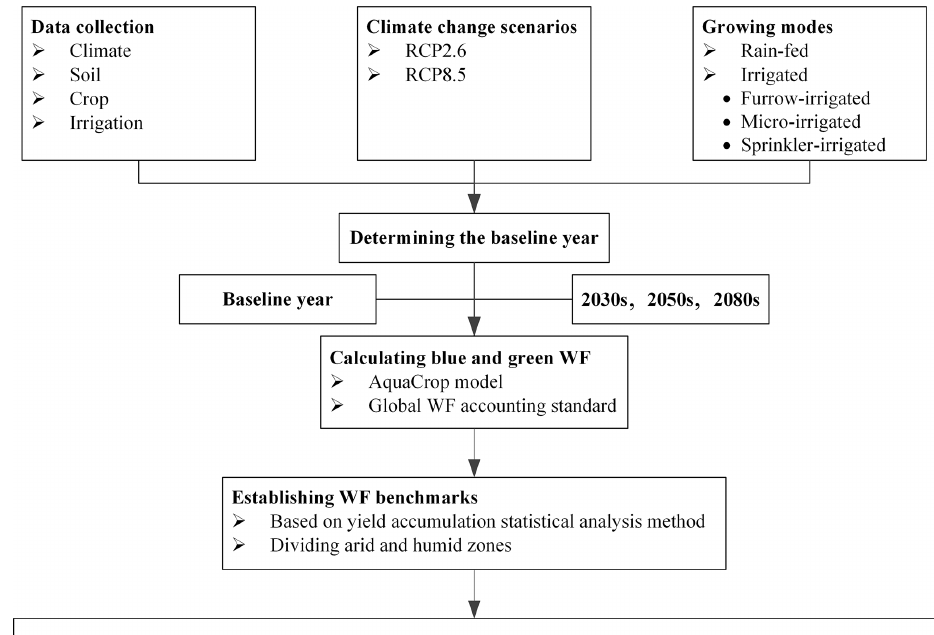
Figure 1. Flow chart for the